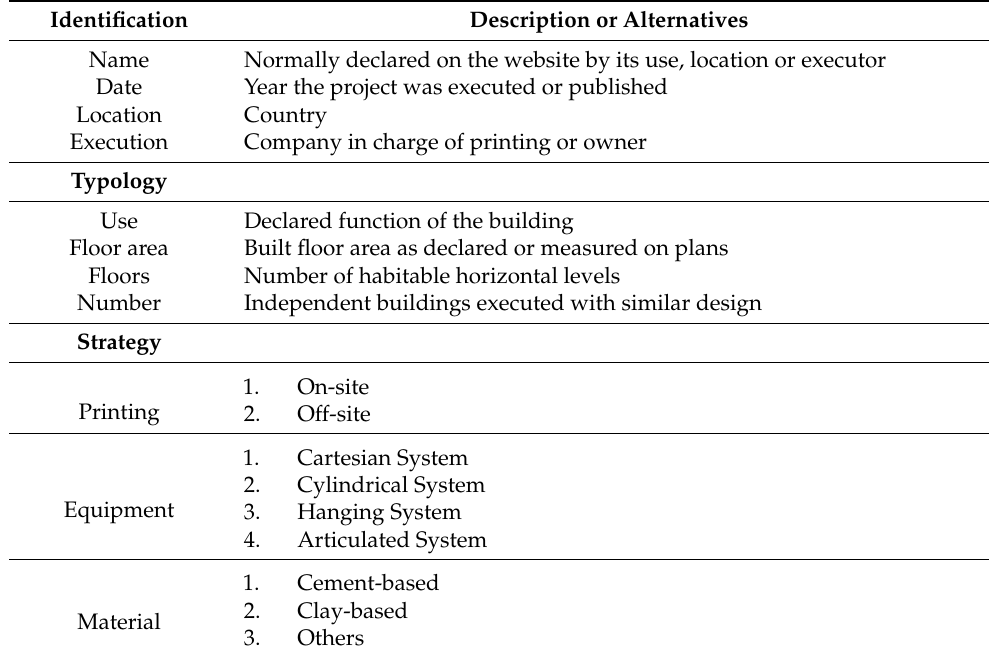
Table 1. General